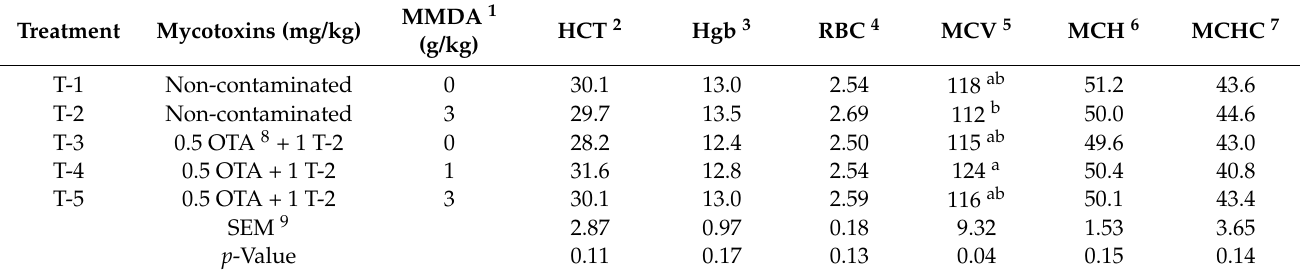
Table 5. The effects of feeding ochratoxin A (OTA) and T-2 mycotoxins and the addition of a binder mycotoxin product (MMDA) on blood hematology (blood count) of broiler